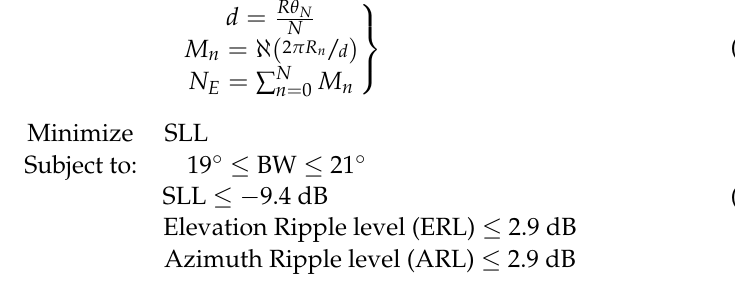
Figure 10. Schematic view of the SA of point sources: ( a ) elevation plane; ( b ) azimuth plane. The objective function and constraints were set in reference to the performance output of the GFA, as given in Equation (39). The optimization process was also repeated for several iterations until the final range of values of the design variables was obtained as given in Table 5. The final model of the SA that satisfied the desired specification was obtained, as presented in Table 6. Based on Equation (38), the performance on Table 6 was obtained at d = 48.9 mm because R = 800 mm and θ N = 35 ◦ . The graphical plots of the beam pattern for the elevation plane, azimuth plane, and three-dimensional space are shown in Figure 11a–c, respectively.